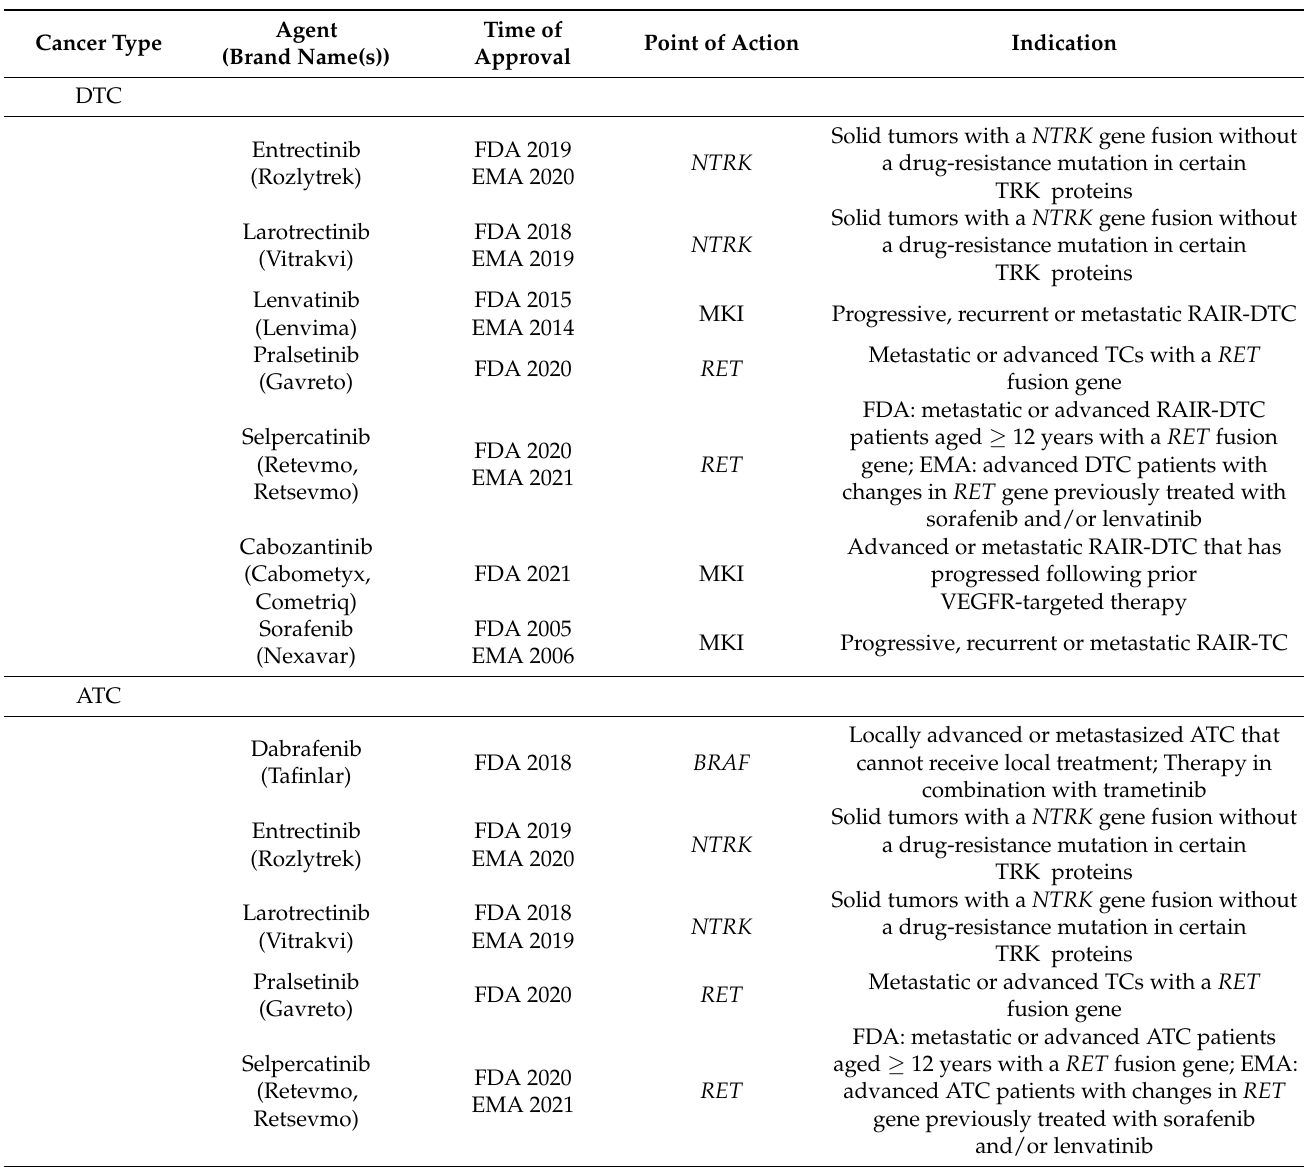
Table 1. Kinase inhibitors currently approved for thyroid cancer (TC) treatment. Cancer